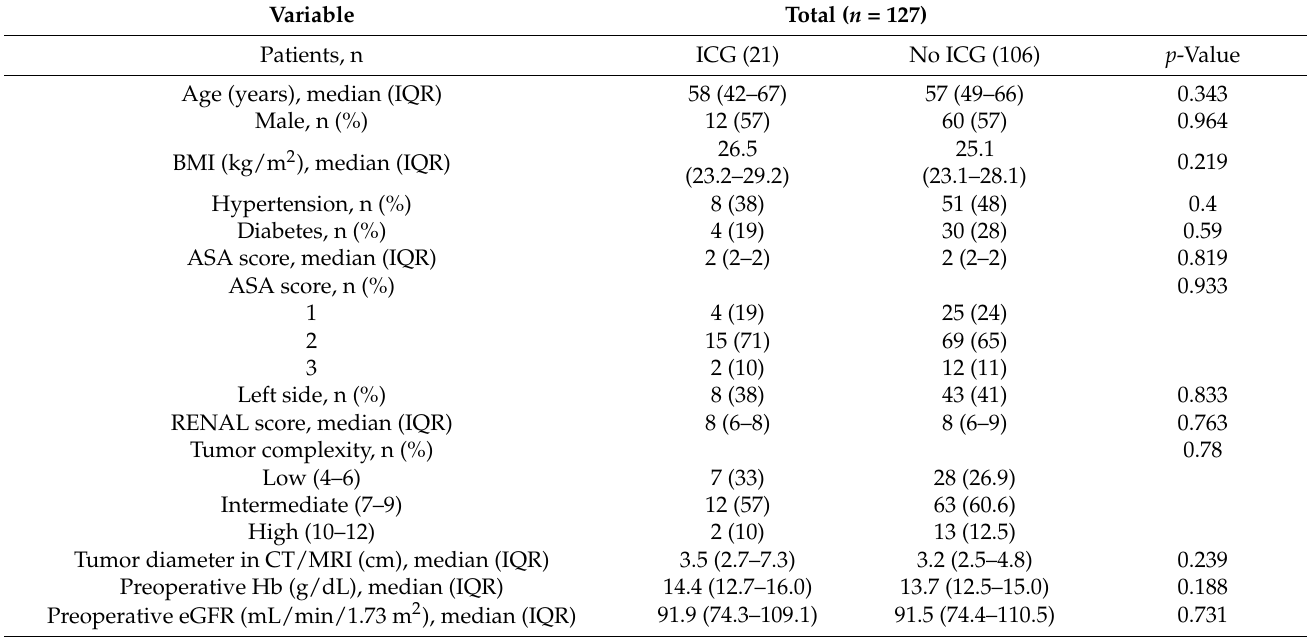
Table 1. Baseline and clinical data of participants.